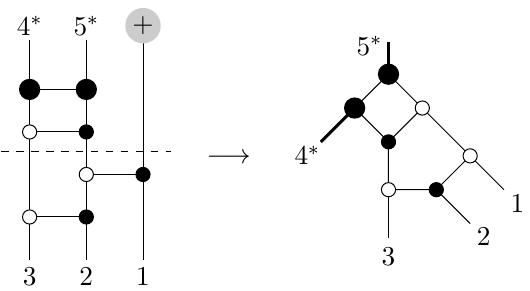
Figure 6 . On-shell diagram construction via BCFW bridges for A (cid:3)